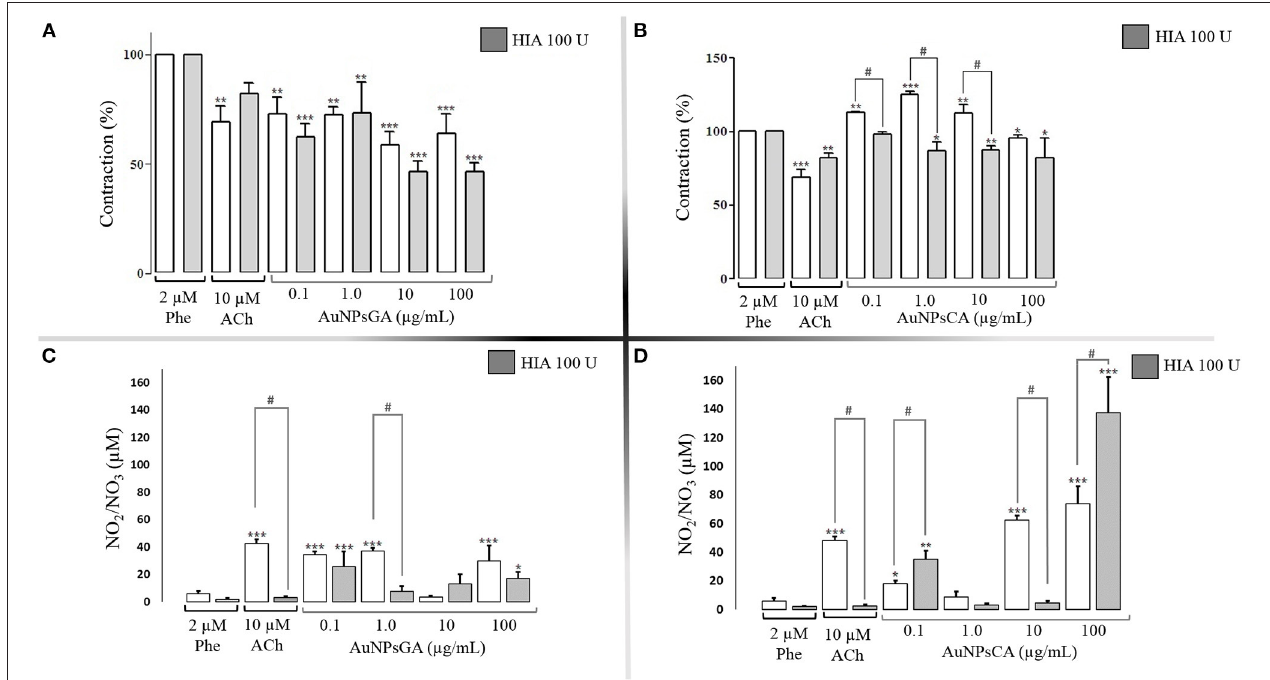
FIGURE 5 | Effects induced by AuNPsGA and AuNPsCA previously treatment with HIA 100U. Percentage of contraction induced by single concentrations of AuNPsGA (A) 0.1, 1.0, 10 and 100 µ g/mL, and (B) singles doses of AuNPsCA (A) 0.1, 1.0, 10, and 100 µ g/mL. Graphics A and B show aortic ring contraction with previous treatment with either 0U HIA (white bars) or 100U HIA (gray bars) on precontracted aortic rings with Phe 2 µ M. The contraction was calculated as the percentage of tension based on 100% contraction induced by Phe 2 µ M. Results are representative of three independent experiments. NO production, in the presence of AuNPsGA (C) and AuNPsCA (D) (0.1, 1, 10, and 100 µ g/mL), also with previous treatment with either 0U of HIA (white bars) or 100U HIA (gray bars). NO levels were determined by Griess method. Values are represented as mean ± SEM ( n = 3). * P < 0.05, ** P < 0.01 and *** P < 0.001 vs. control with Phe (white bars) or the control with Phe and 50U HIA (gray bars). # P < 0.001 differences between no presence of HIA 50U and presence of HIA